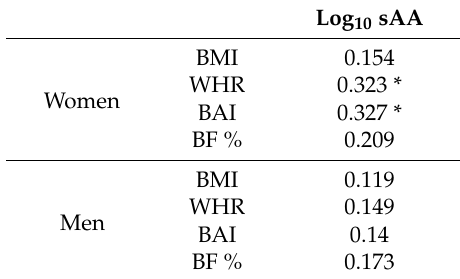
Table 2. Correlation between salivary alpha-amylase and anthropometric